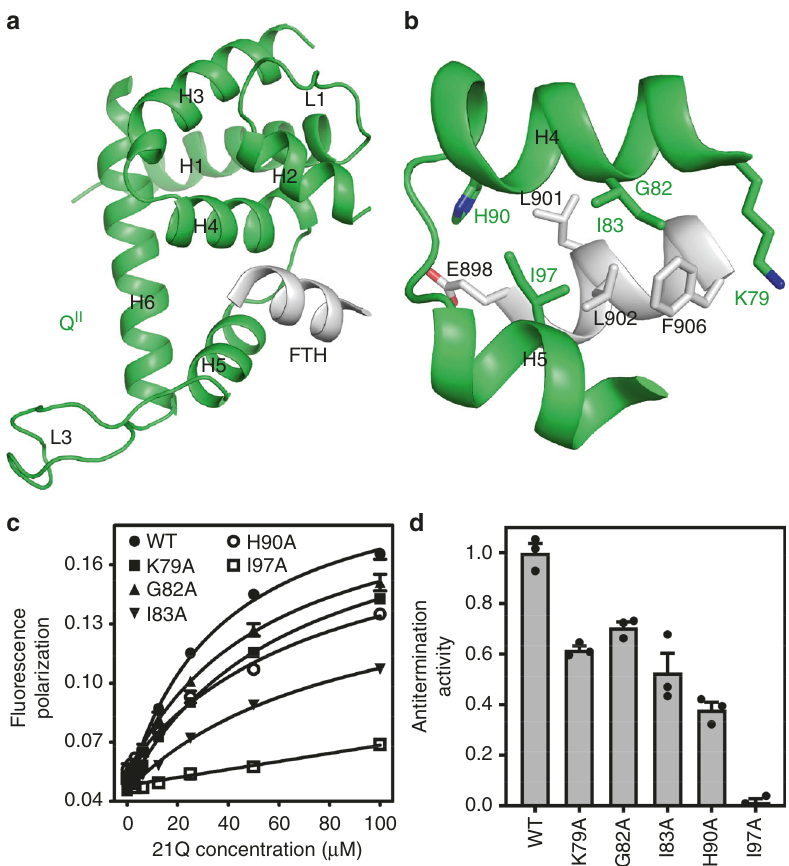
Fig. 5 Q II -RNAP interaction that mediates Q II engagement. a The FTH binds to a groove on Q II . Green, Q II ; gray, FTH. b Interactions between H4, H5 and FTH. c Effects on 21Q-FTH binding af fi nity of substitutions of H4 and H5 (mean ± SEM; 3 determinations). d Effects on antitermination of substitutions of H4 and H5 (mean ± SEM; 3 determinations). Error bars represent mean ± SEM out of n = 3 experiments. Source data are provided as a Source Data fi